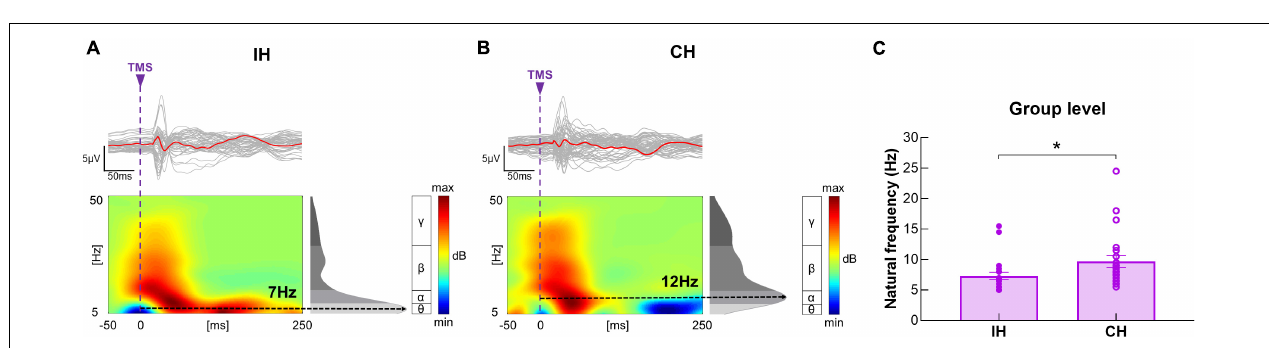
FIGURE 4 | Differences in baseline natural frequency between hemispheres. (A,B) Illustration of TEP, ERSP and natural frequency in the IH and CH in a representative subject. The gray curves represent TEP in each channel, and the red bold curves represent the averaged TEP in the channels surrounding the stimulated motor cortex. The ERSP plots show the TMS-evoked oscillatory responses in amplitude and duration, with black dotted lines highlighting the frequency with the highest power (i.e., natural frequency). (C) Data presented are group mean ± standard error. Baseline natural frequency was significantly slower in the IH compared with CH in the entire sample. The solid circles represent the IH, and the empty circles represent the